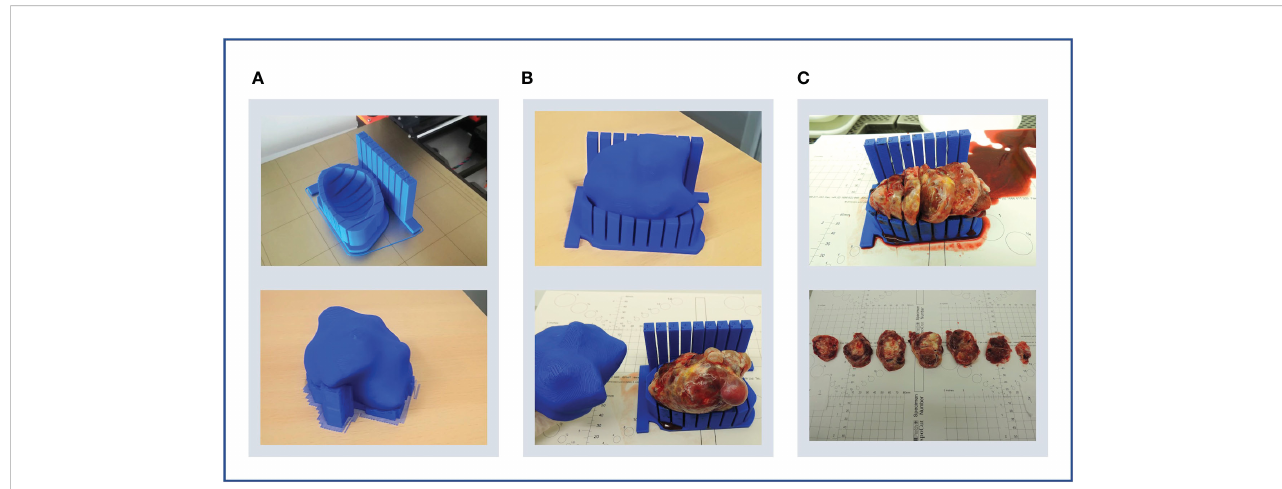
FIGURE 6 Case 2. (A) Upper panel: lesion-speci fi c mould on the print bed. Determining tumour specimen placement based on the shape of the mould cavity alone is challenging, hence a tumour replica is also printed (lower panel). A temporary scaffolding to support the emerging replica during printing is added and easily removed when printing is complete. (B) Upper panel: the tumour replica fi ts the mould closely as the mould and replica are both printed based on the same segmentation. Lower panel: the resection specimen is placed directly into its correct position based on the placement of the replica. (C) Upper panel: the tumour was successfully sliced, but the shallow tumour cavity led to tissue slices overspilling. Lower panel: even with a tumour with macroscopically visible substructures, slice orientation in relation to the mould and to each other is lost on retrieval from the mould.